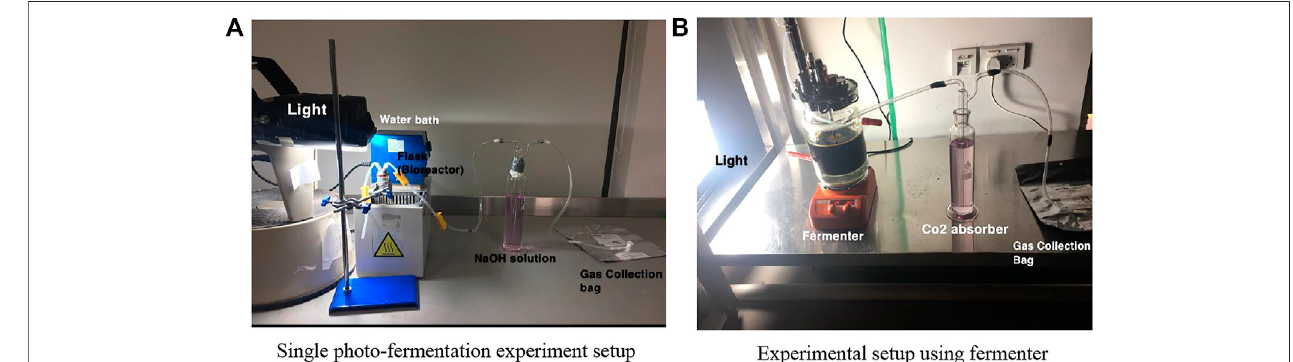
FIGURE 1 | Experimental model system of study.